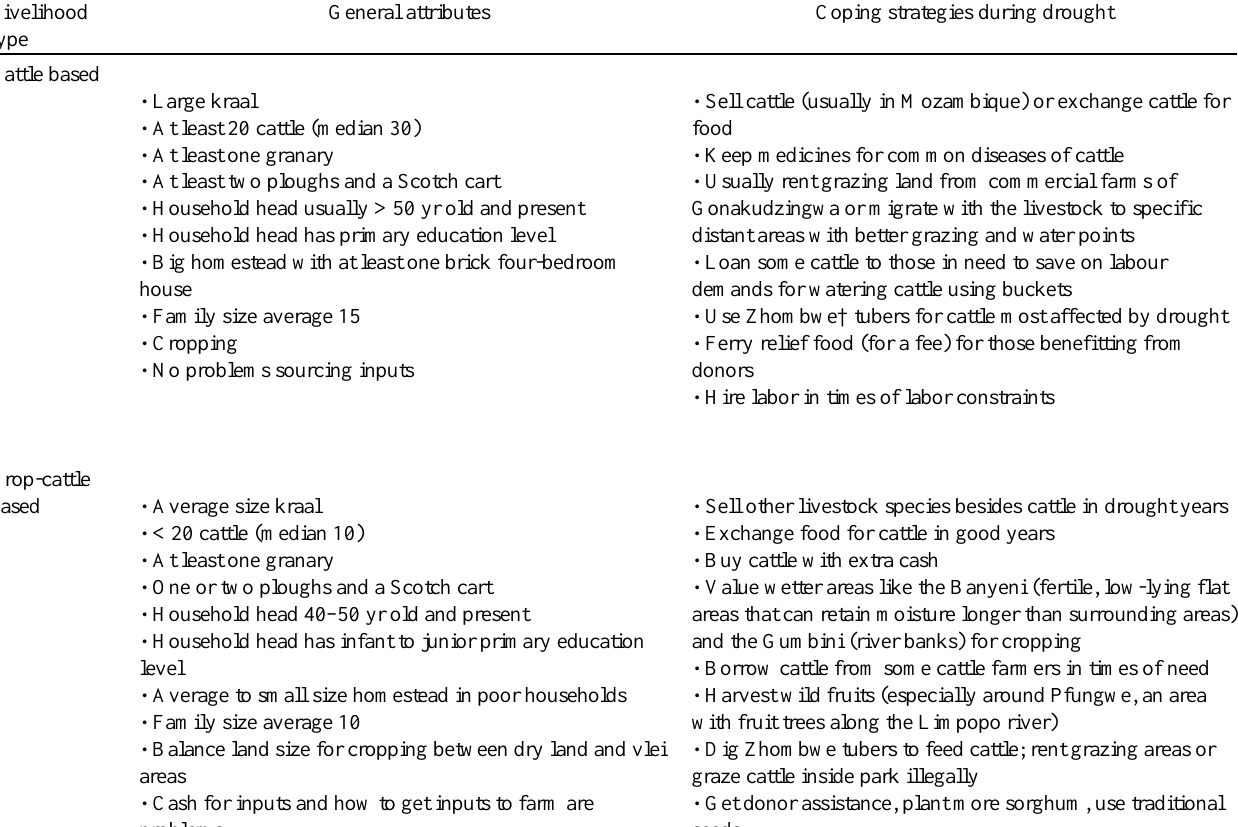
Table 1. General description of livelihood types in southeastern